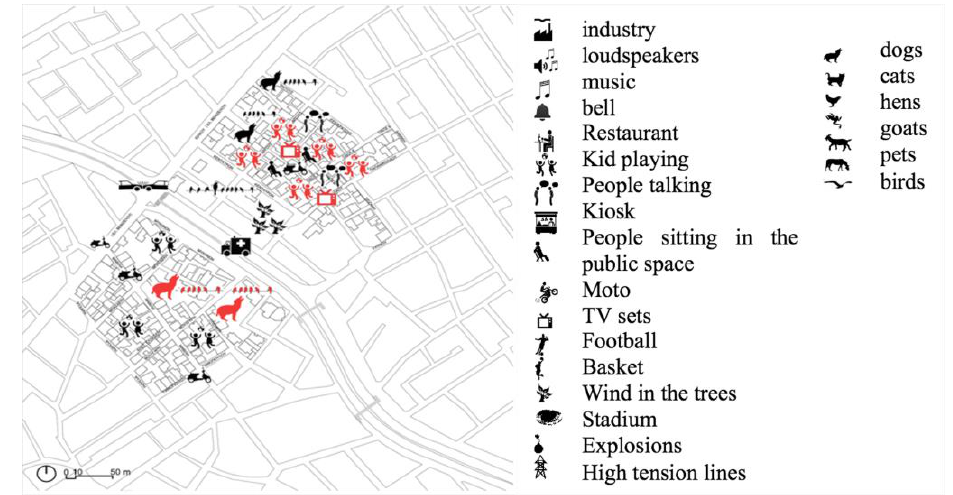
Figure 15. Map of predominant uses in Iolkos UA, Volos.